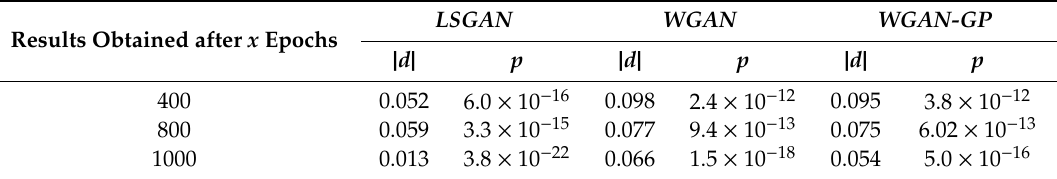
Table 6. Best obtained absolute di ff erence and p value calculations for robust equivalency testing after x number of epochs. Example of GANs trained on a subset of 30 individuals from DS2. LSGAN WGAN Results Obtained after x Epochs